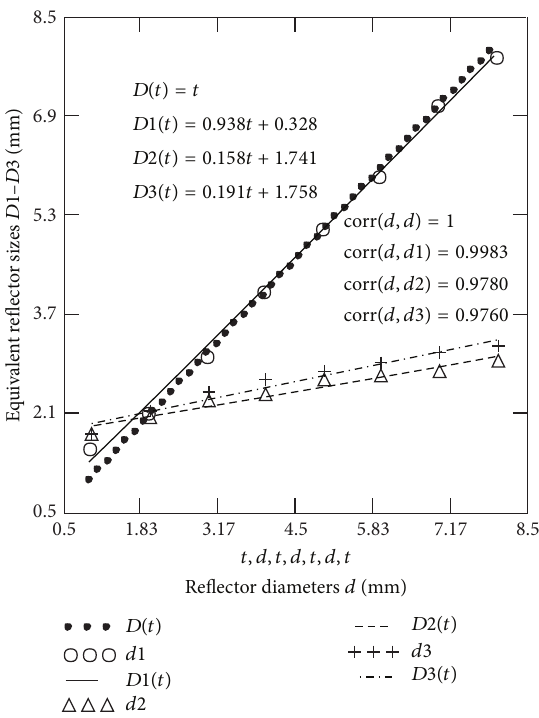
Figure 9: The experimental correlation (corr) of sizes: reflector diameters 𝑑 (real defects) and equivalent reflector sizes (equivalent defects) 𝐷1(𝑡) – 𝐷3(𝑡) ; 𝐷1(𝑡) , 𝐷2(𝑡) , and 𝐷3(𝑡) relating to flat bottom hole, hemispherical bottom hole and side drilled hole, respectively; 𝐷(𝑡) is the theoretical run; 𝑡 is the programme step (1 ⋅ 10 −4 ) within the range of 𝑑 = 1 – 8